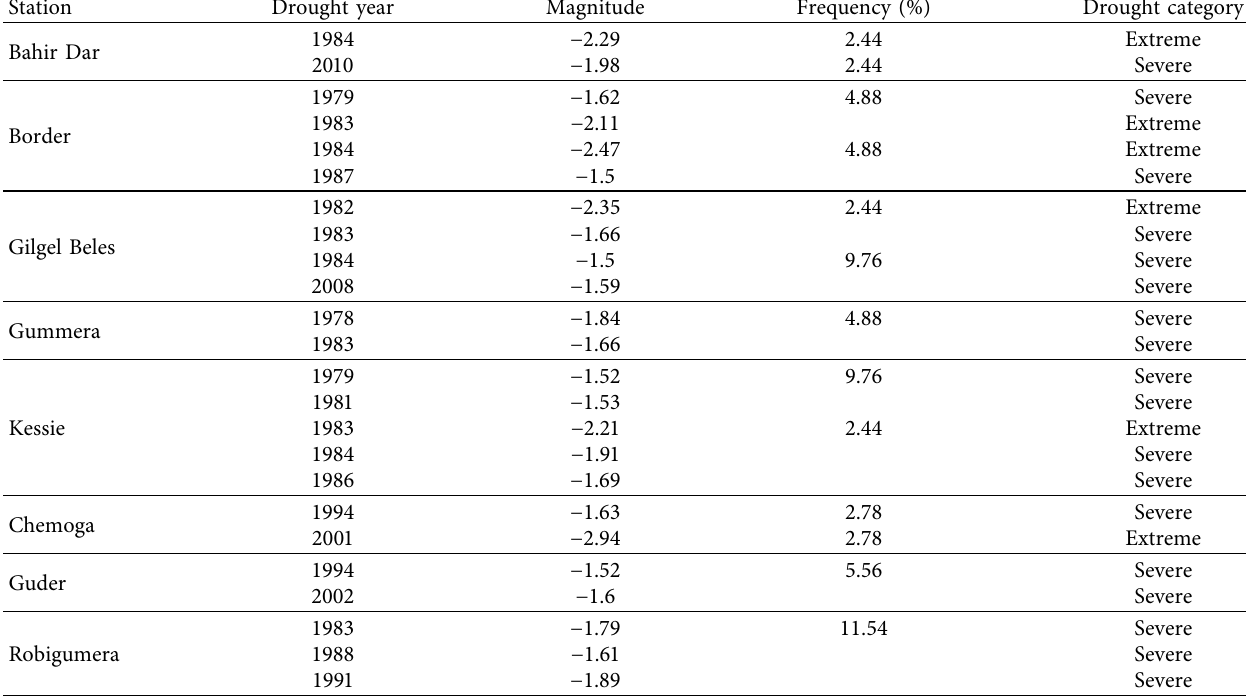
Table 5: Severe and extreme drought years in the Abbay river basin during 1973–2014 in SDI12.